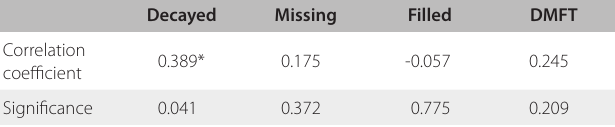
* Statistically significant correlation (p <